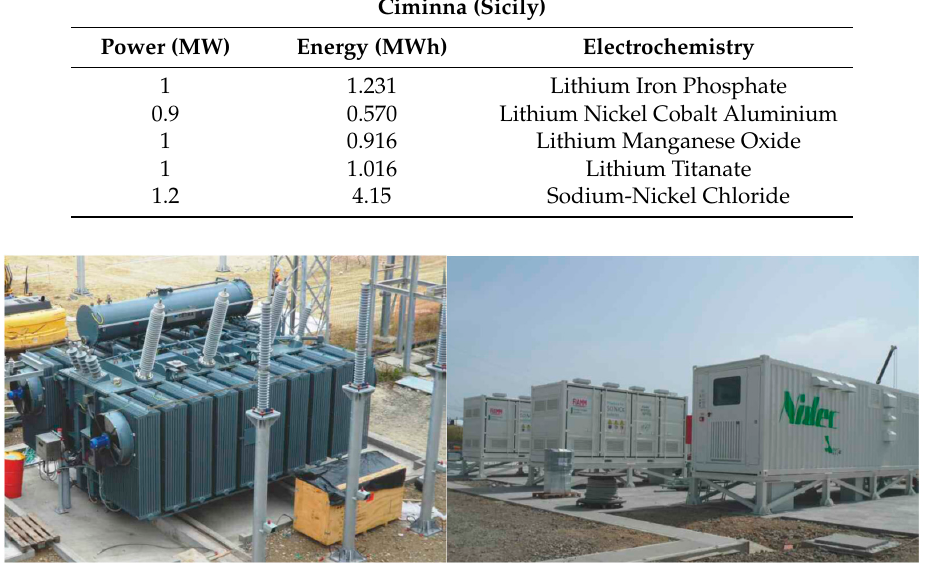
Figure 5. Some photos of the Italian “power intensive” installation (Storage Lab) in Codrongianos.